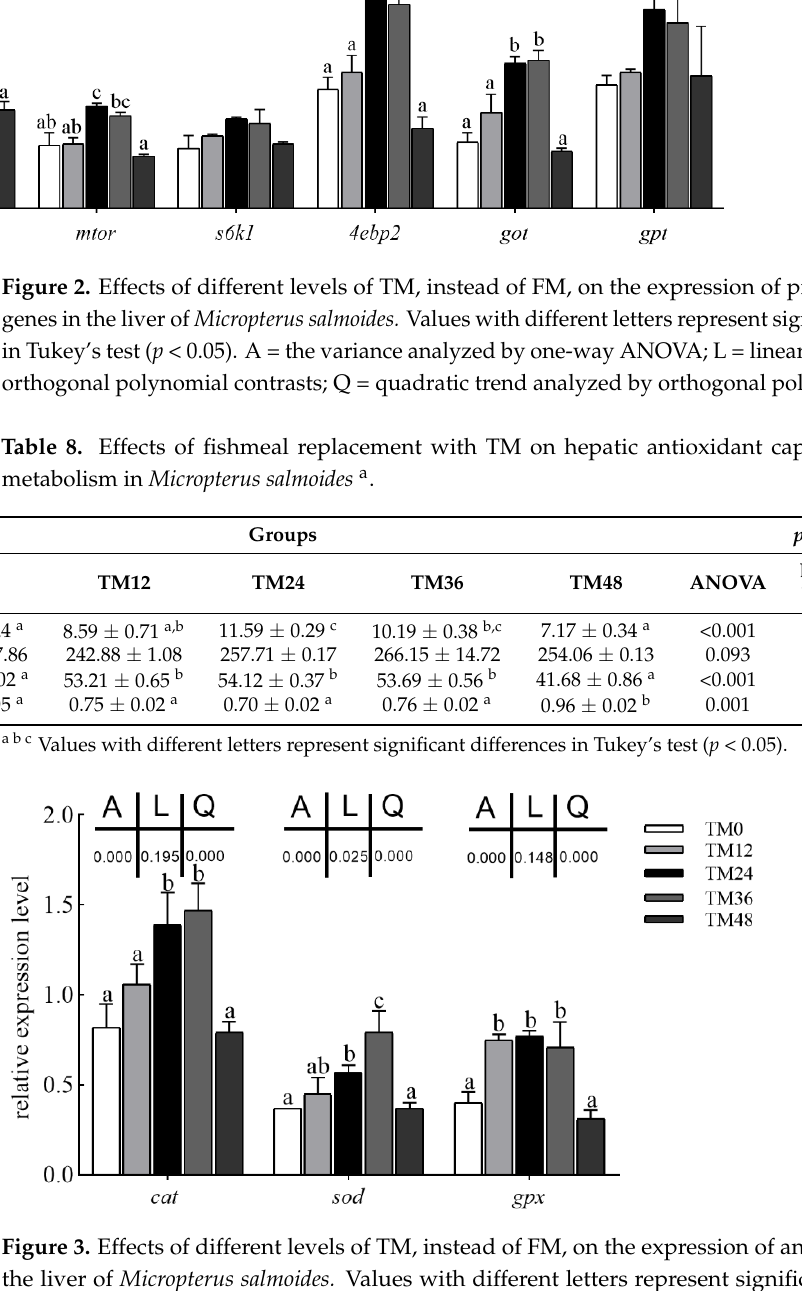
Figure 4. Effects of different levels of TM, instead of FM, on the expression of immune-related genes in the liver of Micropterus salmoides. Values with different letters represent significant differences in Tukey’s test ( p < 0.05). A = the variance analyzed by one-way ANOVA; L = linear trend analyzed by orthogonal polynomial contrasts; Q = quadratic trend analyzed by orthogonal polynomial contrasts. 3.6. Liver Histology The livers of TM0 group were white and swollen, and many hepatocytes were vacu- olated (Figure 5). The livers and their nuclei in the TM24 group were reddish and neatly arranged, respectively. Moreover, many vacuolations were observed in TM48 group hepatocytes.